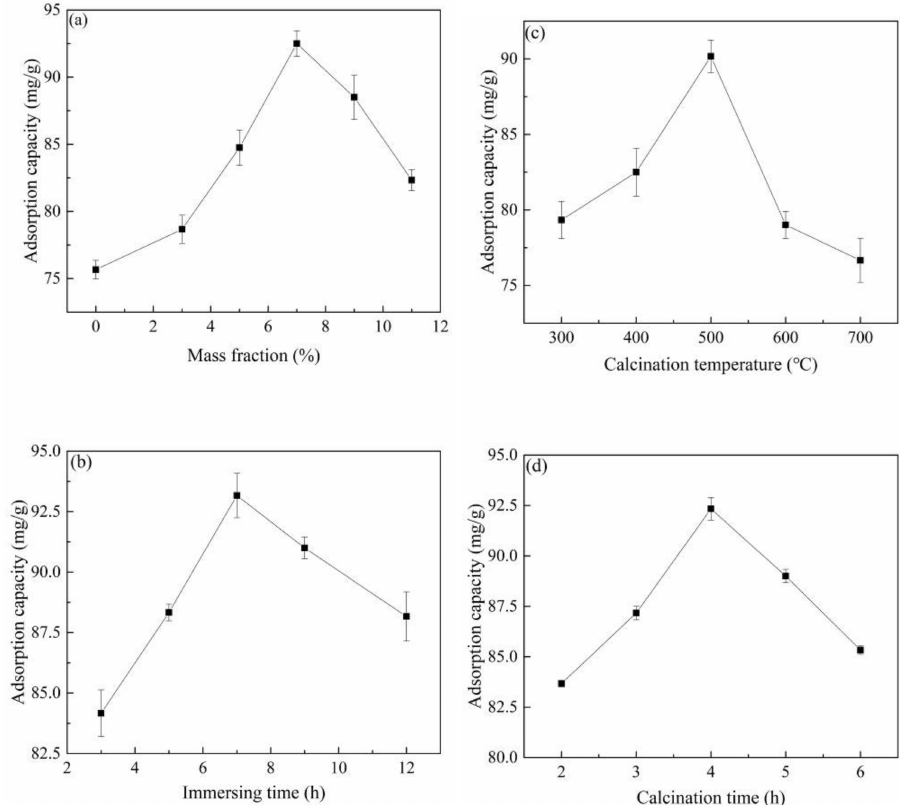
Figure 1. The influence of preparation conditions on material properties: ( a ) Co 2+ concentration of impregnation solution, ( b ) immersing time, ( c ) calcination temperature, ( d ) calcination time. (atrazine concentration 10 mg/L, material dosage 60 mg/L, reaction time 180 min, reaction temperature 25 ◦ C and shaking speed 120